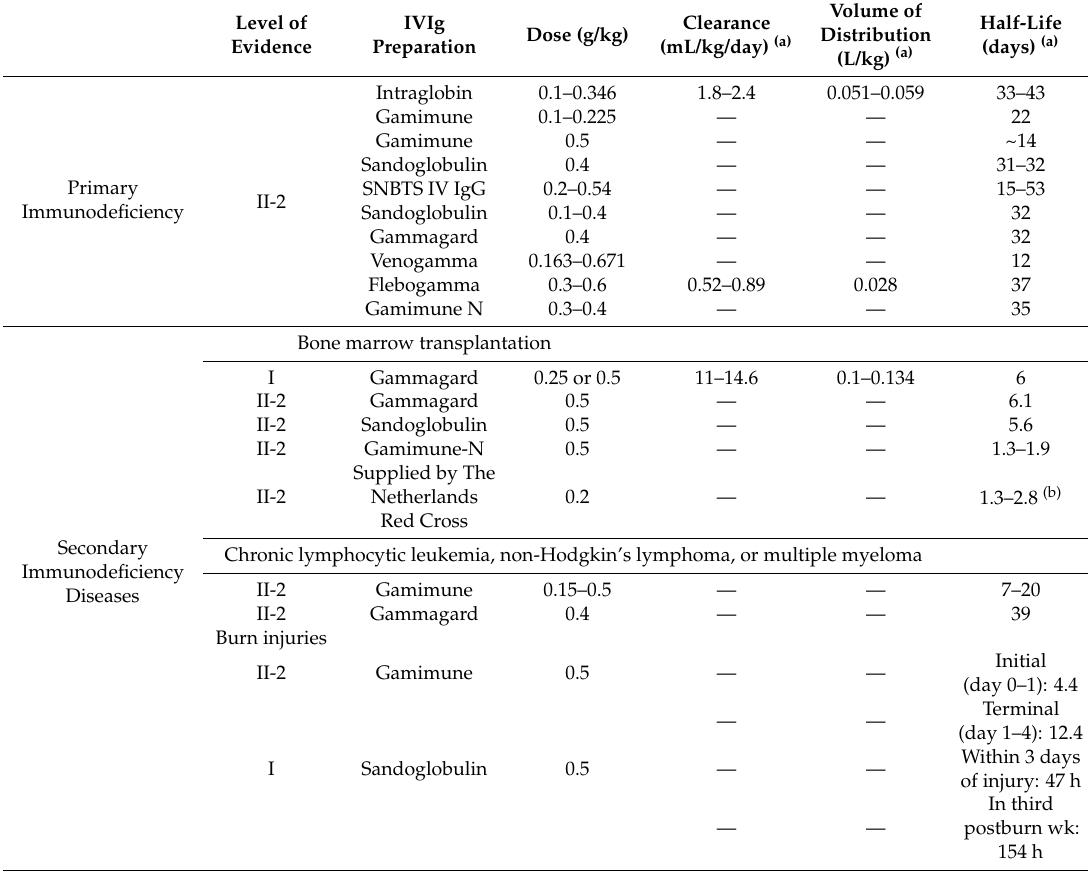
Table 1. Pharmacokinetic parameters of commercialized IVIg in Primary Immunodeficiency Diseases and Secondary Immunodeficiency Diseases